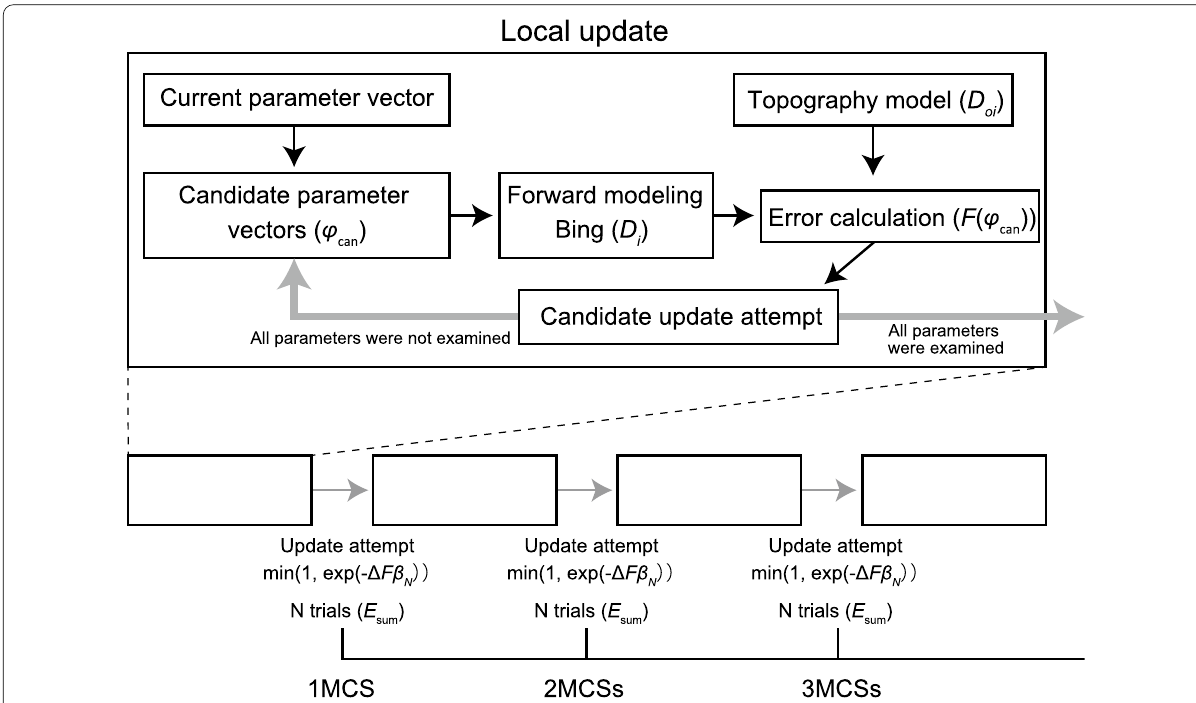
Fig. 2 Schematic flowchart of the Markov Chain Monte Carlo (MCMC) method for our inversion analysis. MCS Monte Carlo